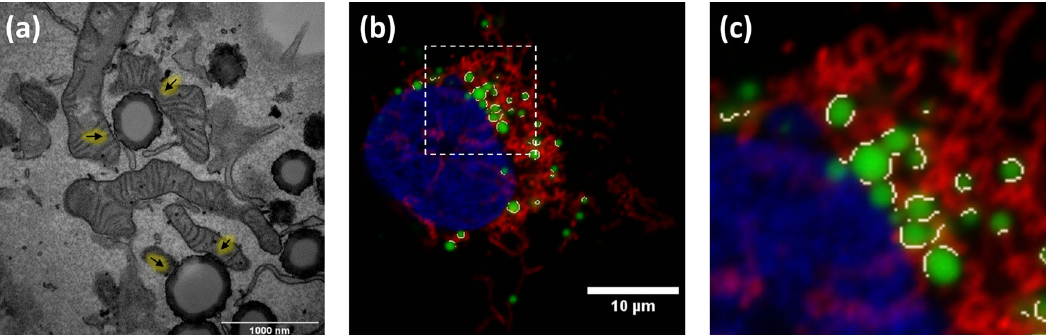
Figure 3. (a) TEM image showing LD-mitochondria contacts indicated by arrows, (b) result of the LD- mitochondria contacts (in white) detected by ContactJ in fluorescence microscopy image in Hek293 cells labelled with anti TOM20 antibody (mitochondria) in red, Bodipy493/505 (LDs) in green and DAPI (nuclei) in blue; and (c) magnification of the square region of (b) showing the contacts in